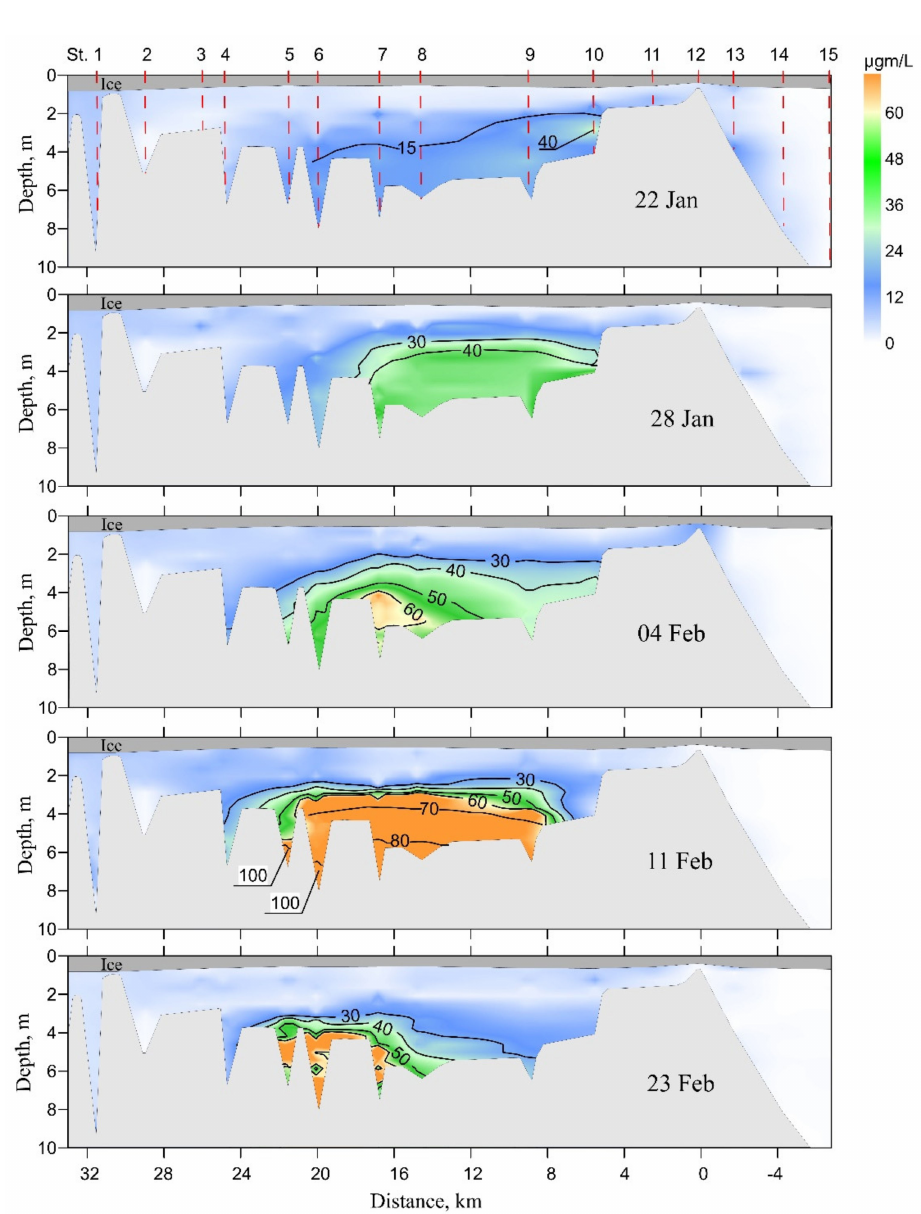
Figure 4. Chl-a concentration on transect obtained from 22 Jan. 2022 to 23 Feb. 2022. The position of monitoring stations is shown by dotted red lines. Positive values on the x -axis—distance from the river mouth bar (St. 12) to upstream, negative values—to